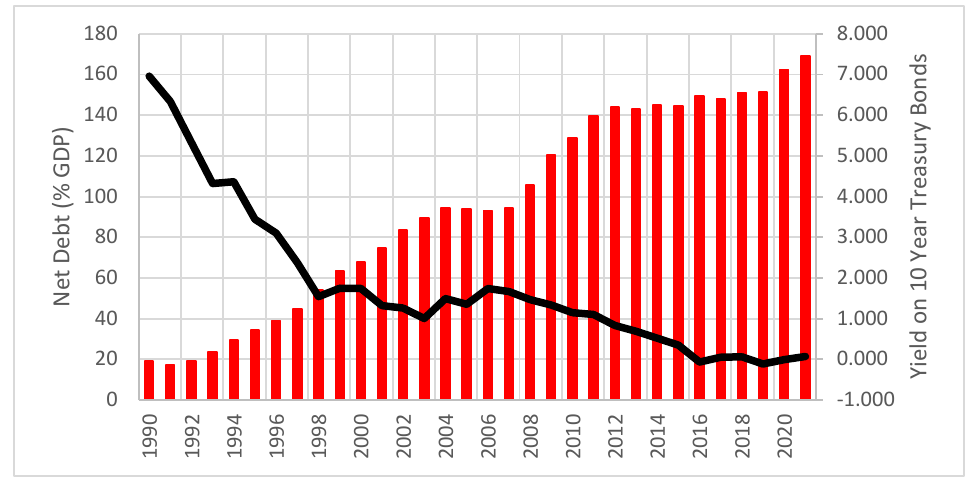
Figure 4. Japanese government trends in net debt (% GDP, bars) and yield to maturity on 10-year Japanese government bonds (solid line). Data: IMF [40] and OECD [47].